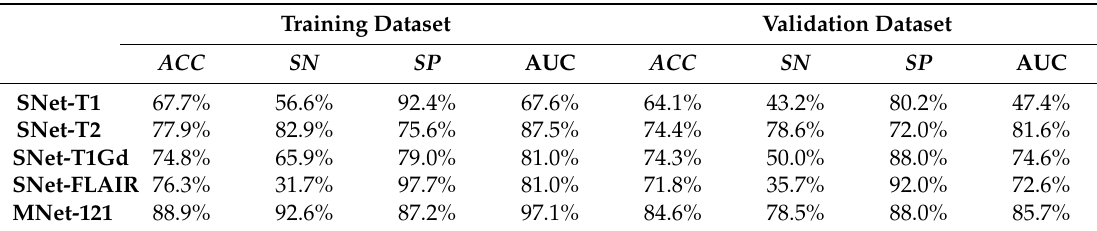
Table 4. Comparing the performance between single-modality and multi-modality model.